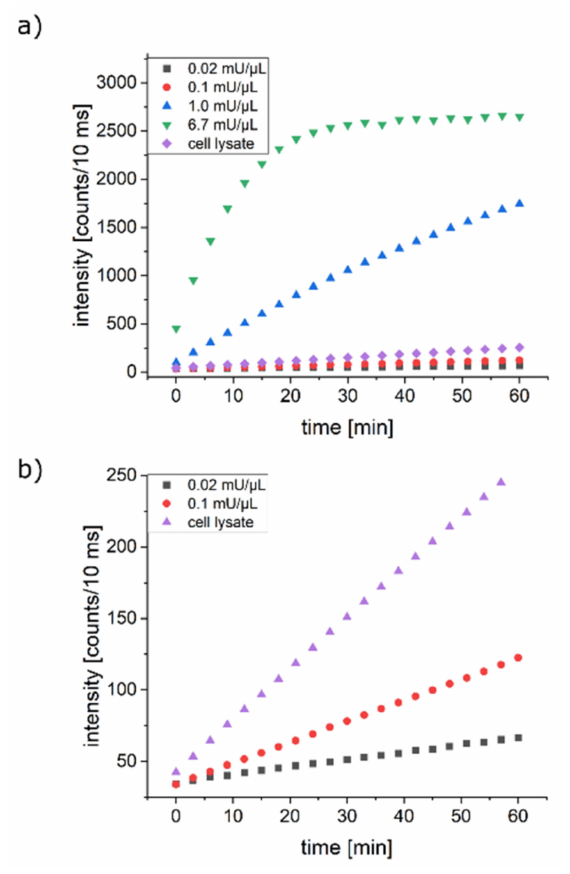
Figure 2. ( a ) Fluorescence intensity changes with time of the Ap4 analog 2 in a buffered solution with different concentrations of snake venom phosphodiesterase I (SVPD) and in cell lysate. ( b ) Zoom into the lower intensity region of ( a